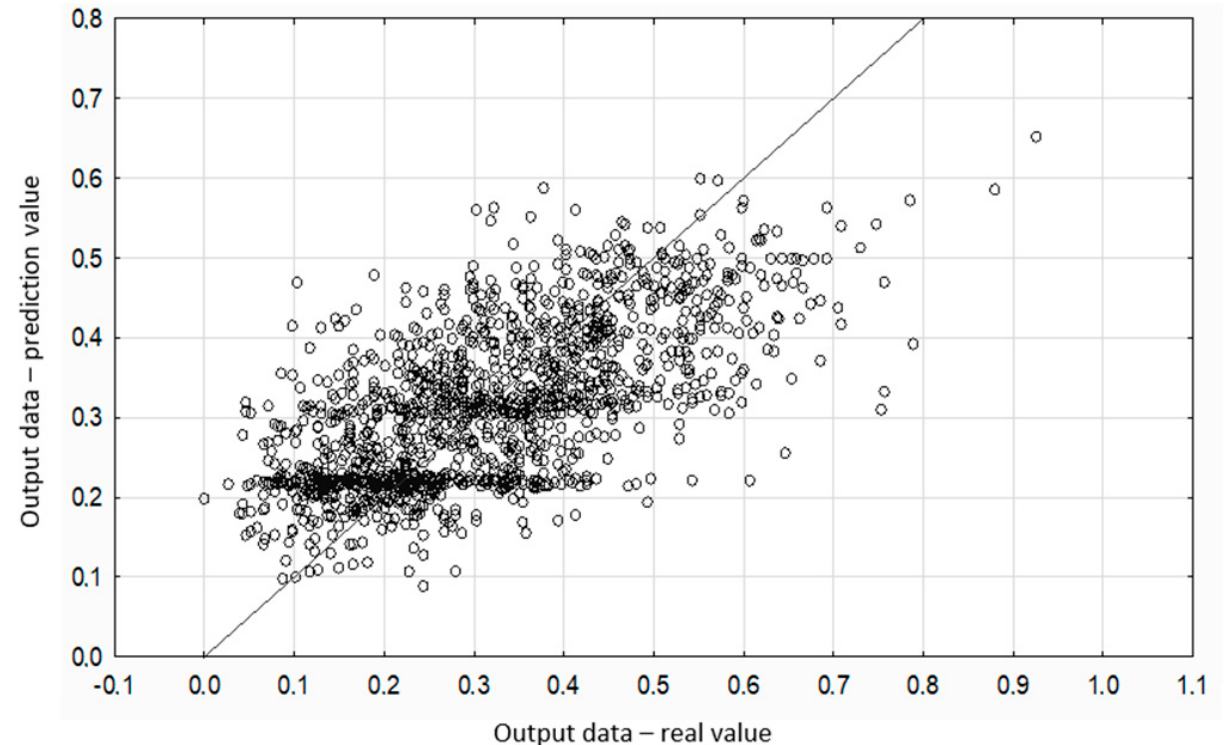
Figure 5. Axle radial runout—prediction and real values comparison. Table 2. Set of interneural weights of network MLP